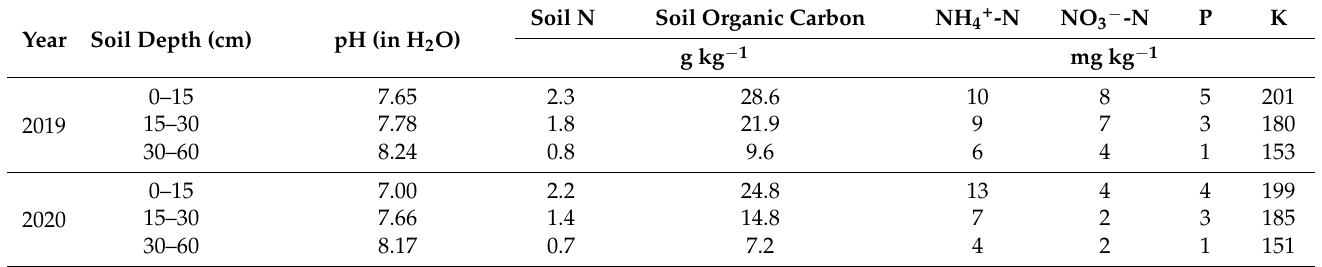
Table 2. Summary of average initial soil properties of the experimental site at different soil depths in 2019 and 2020 at Swan Lake Research Farm, near Morris,